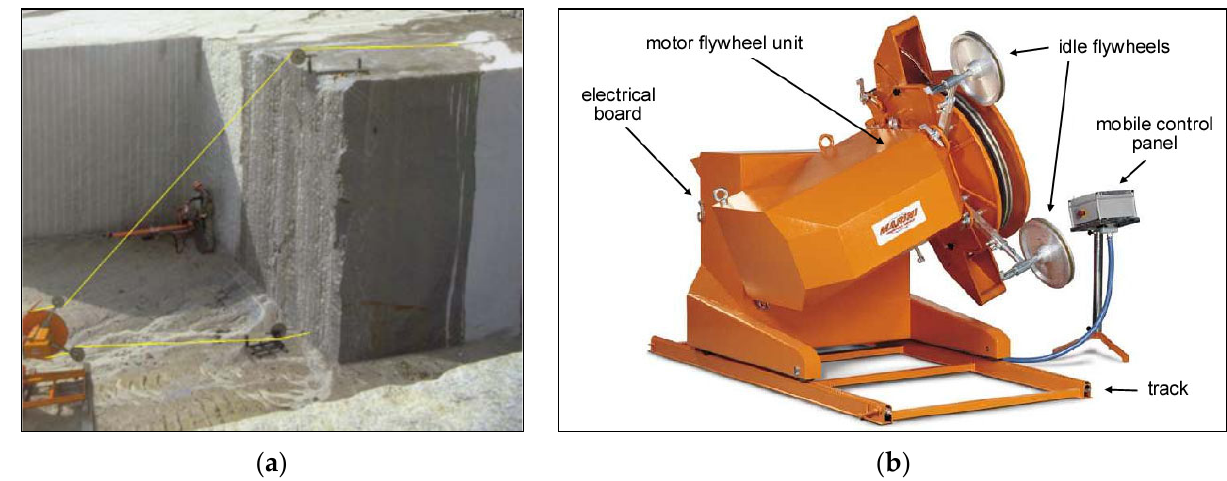
Figure 6. ( a ) Cutting by diamond wire through a traditional “descending loop” configuration; ( b ) the diamond wire sawing machine, where the main components are shown.